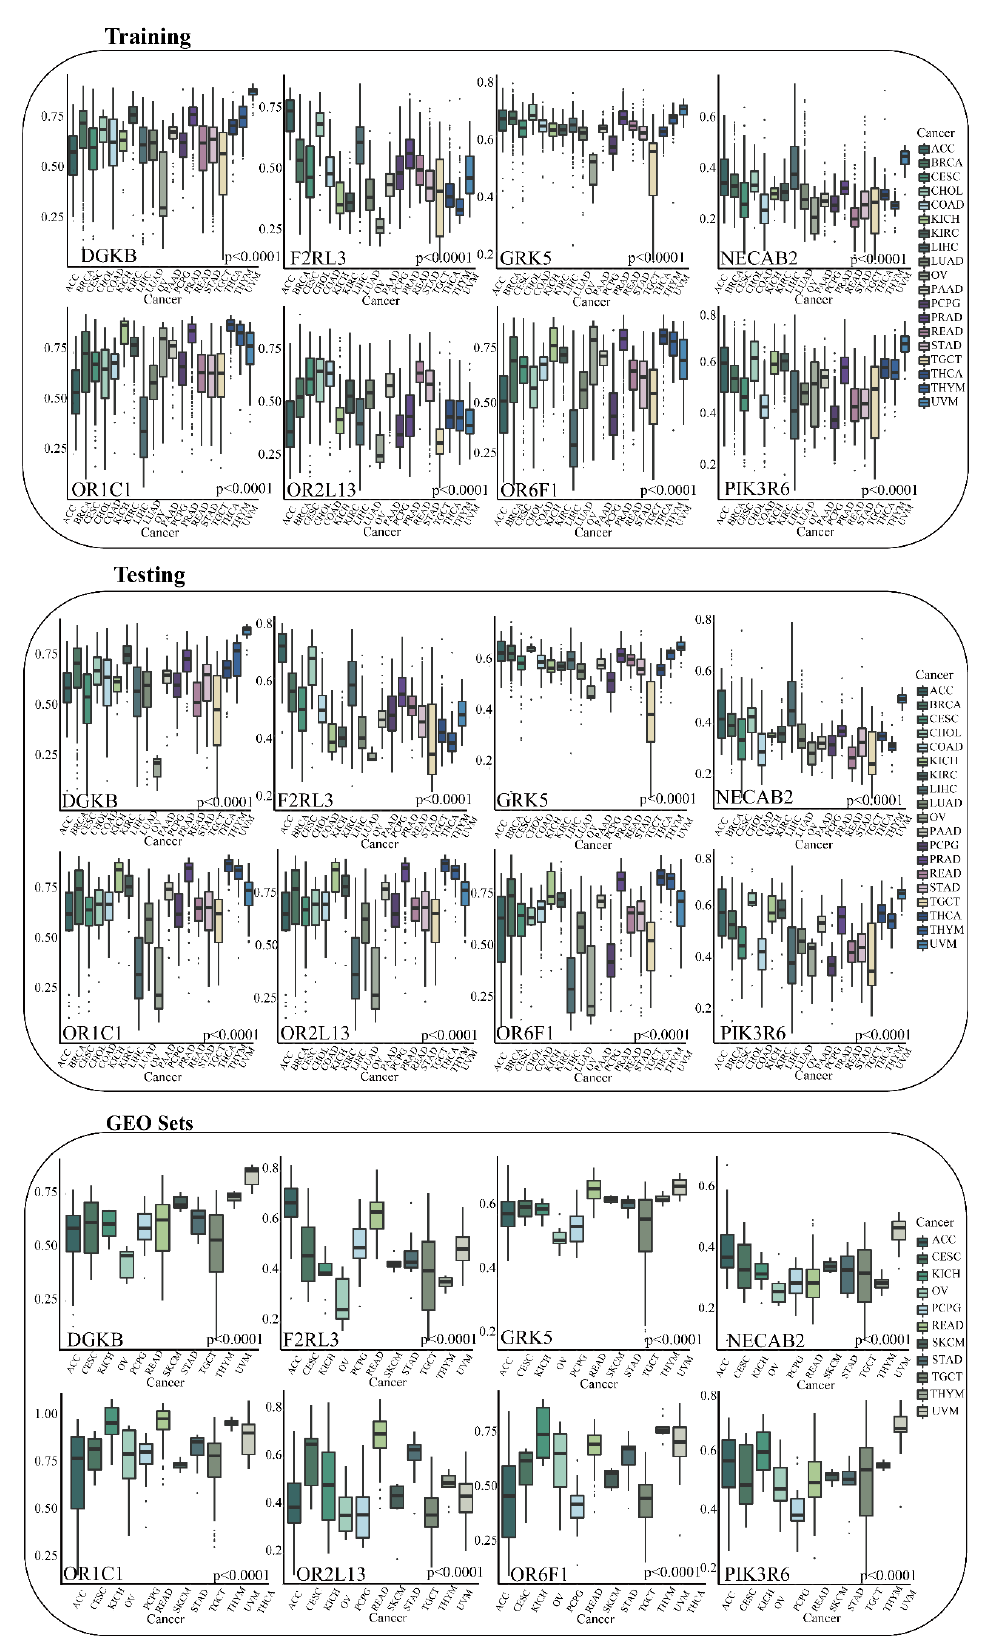
Figure 5. The validation of GRSDMs in training, testing and GEO validation sets.